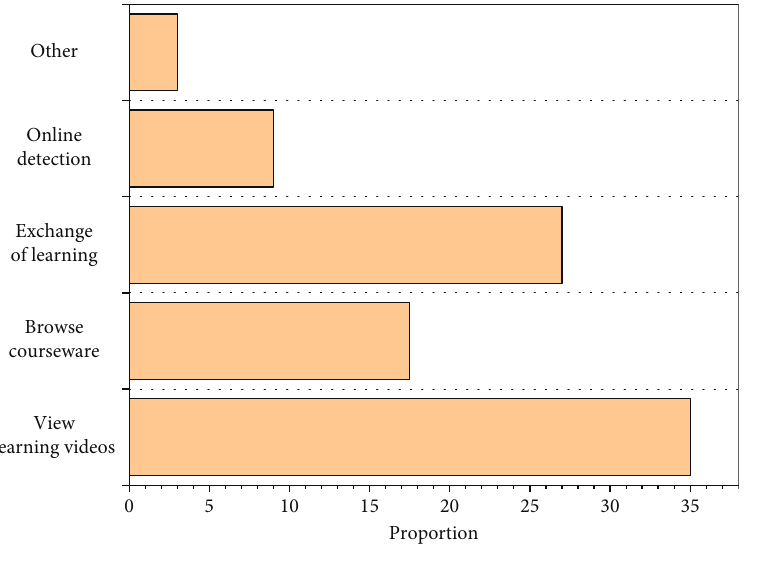
Figure 3: Function survey of network teaching platform.